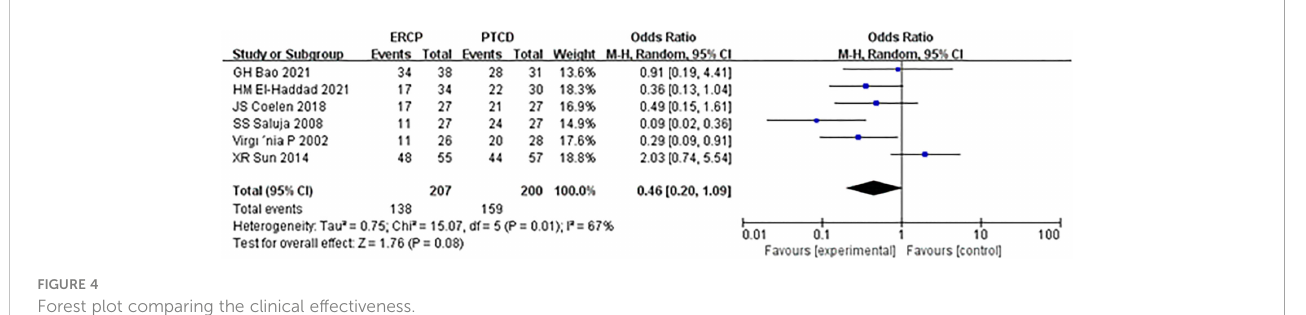
FIGURE 4 Forest plot comparing the clinical effectiveness.